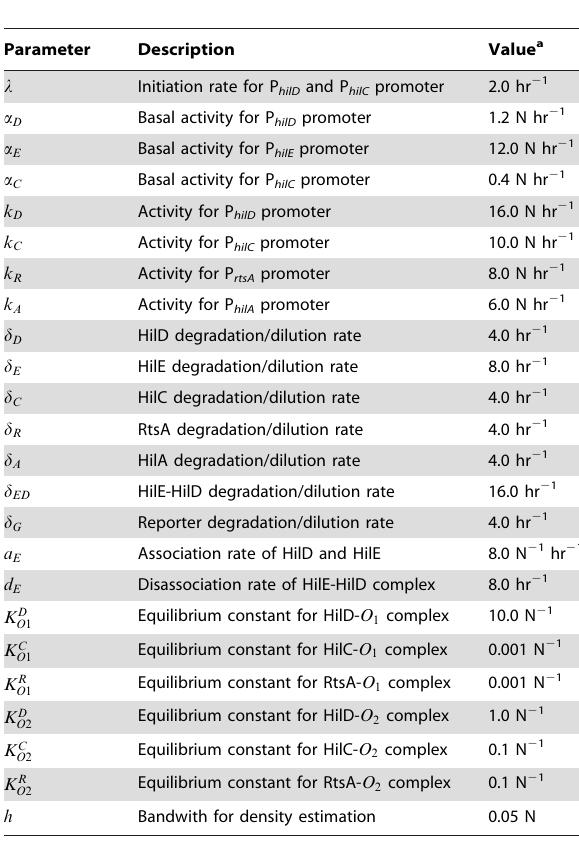
Table 3. Parameter definitions and nominal